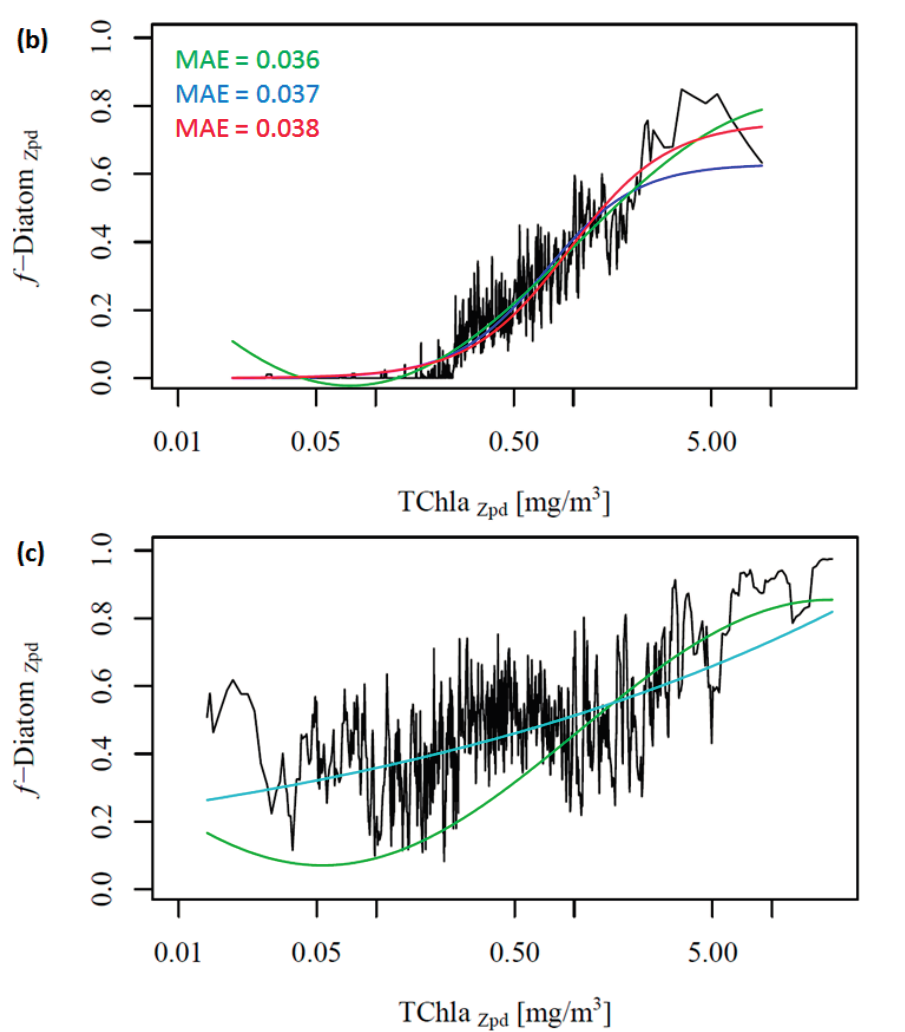
as a function of TChla Zpd